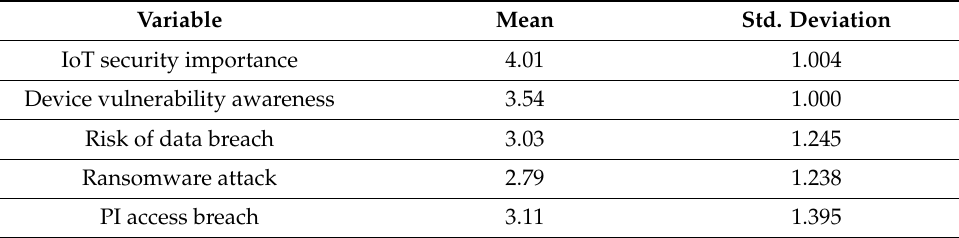
Table 4. Descriptive statistics of variables ( n =